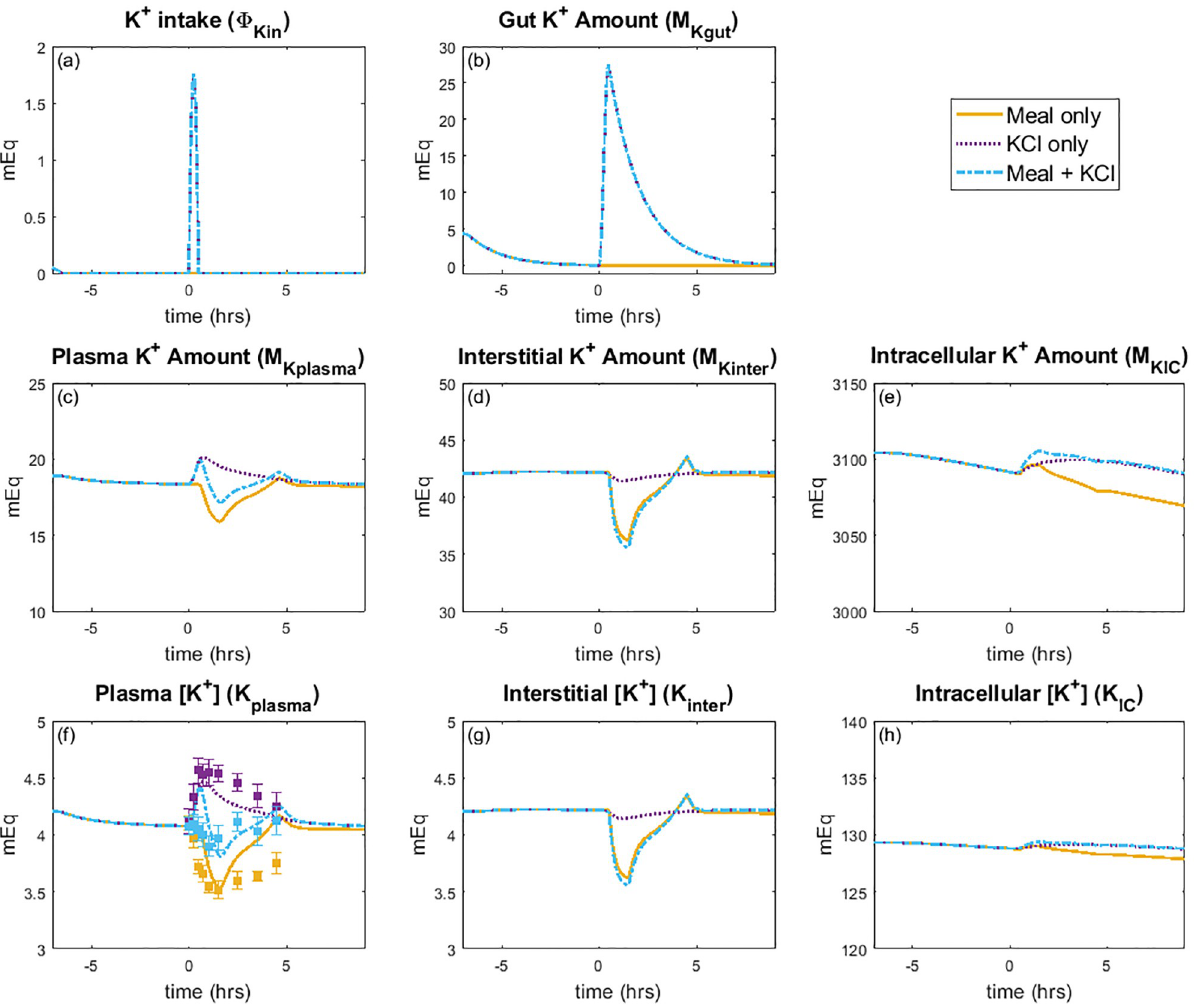
Fig 4. Extracellular and intracellular K + response to a single meal. (A) Prescribed K + intake, (B)-(E) predicted K + amount in various compartments, and (F)-(H) predicted K + concentrations for a single meal load. The meal experiment occurs at time = 0 hours. Initial conditions are the baseline steady state values (see Table 2) followed by a fasting state set before the meal experiment. The yellow lines denote the K + deficient meal (i.e., “Meal only” experiment); purple, only K + ingestion (i.e., “KCl only” experiment); blue, meal with K + (i.e., “Meal + KCl” experiment). Points and error bars for plasma K + concentration (f) show experimental data from Preston et al.